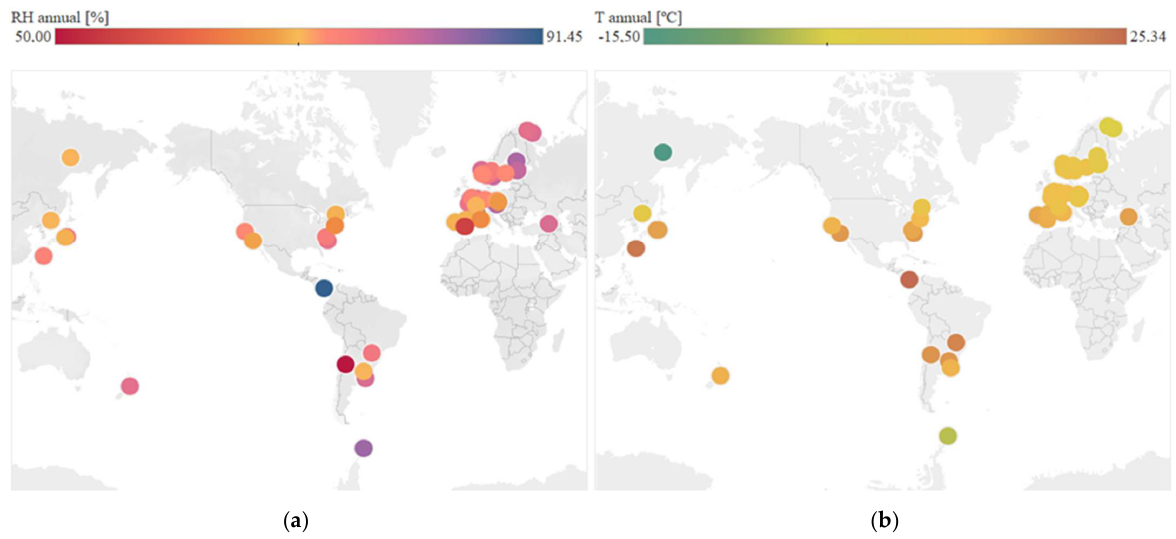
Figure 4. Analysis of continuous variables at each location. ( a ) Distribution of mean annual relative humidity. ( b ) Distribution of mean annual temperature.